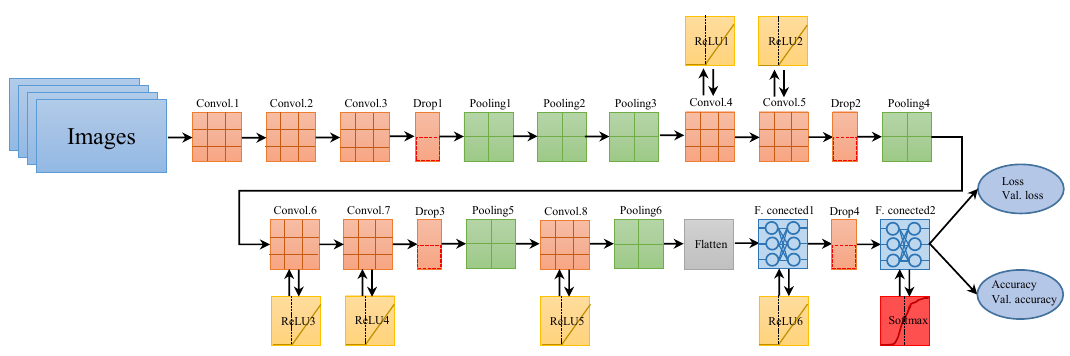
Figure 2. Convolutional neural network for scene